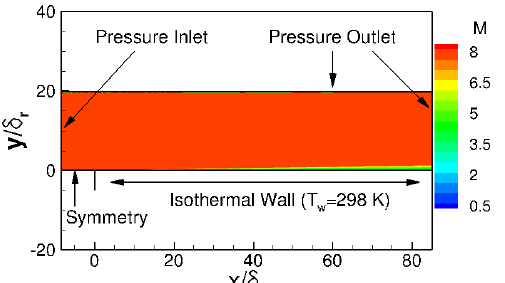
Figure 2. Computational domain and simulation setup for Reynolds-Averaged Navier-Stokes (RANS) of a Mach 8 turbulent boundary layer developing spatially over a flat plate, with the start of plate at x / δ r = 0. Here, δ r = 35.3 mm is the boundary-layer thickness at the center of the domain. The contours of Mach number are shown in the domain.